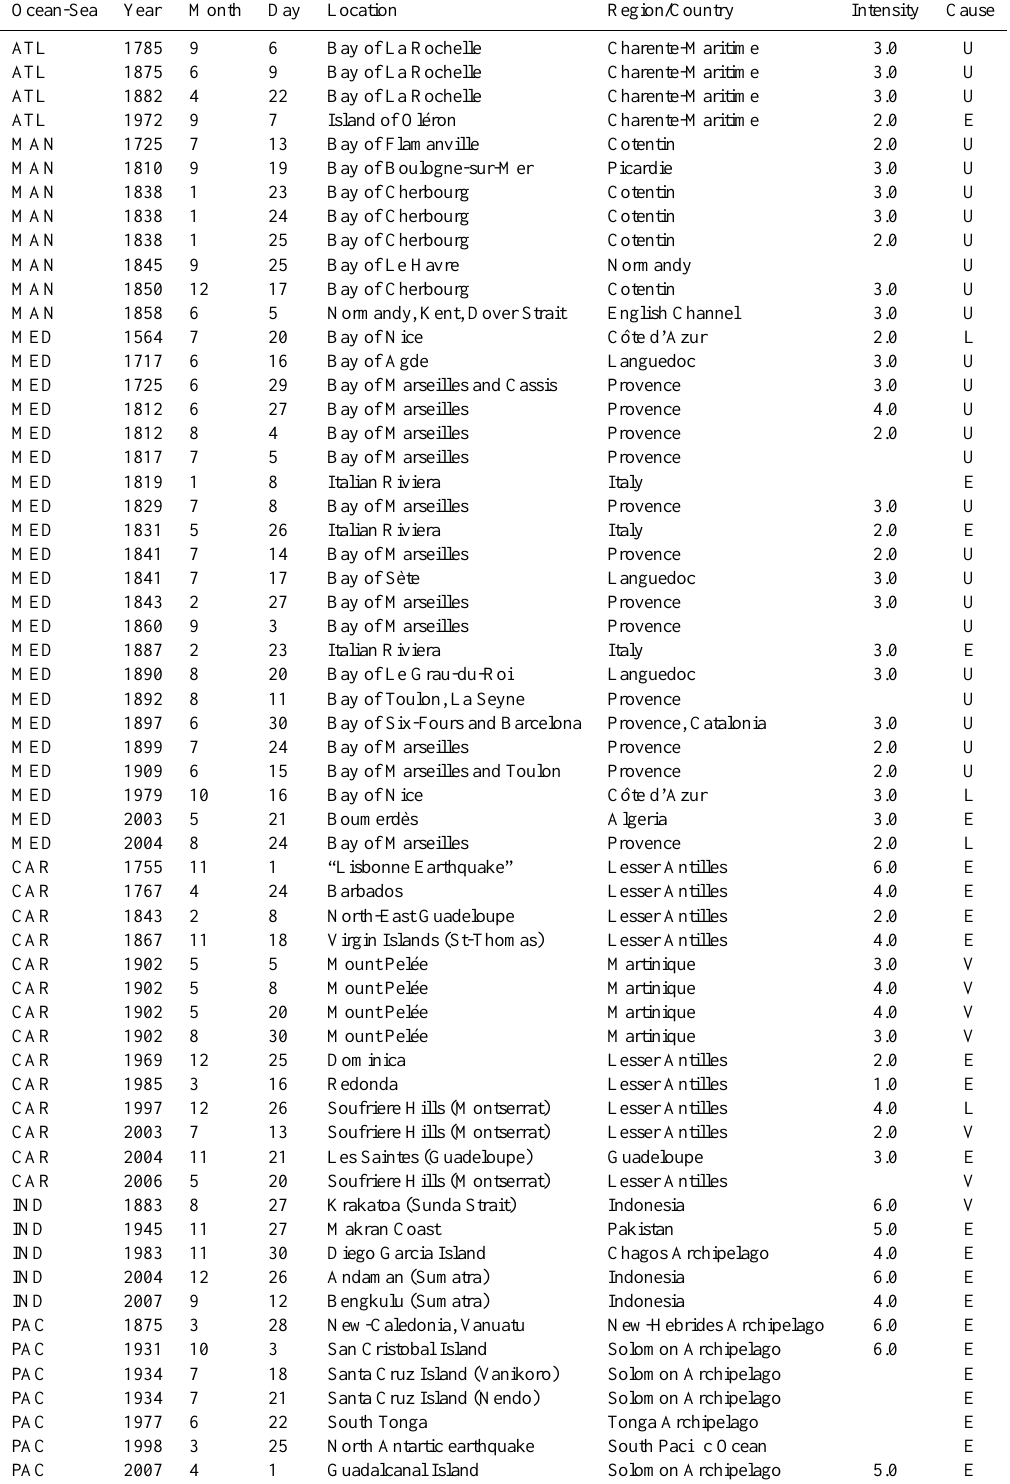
Table 1. “True” tsunamis referenced in the French database.